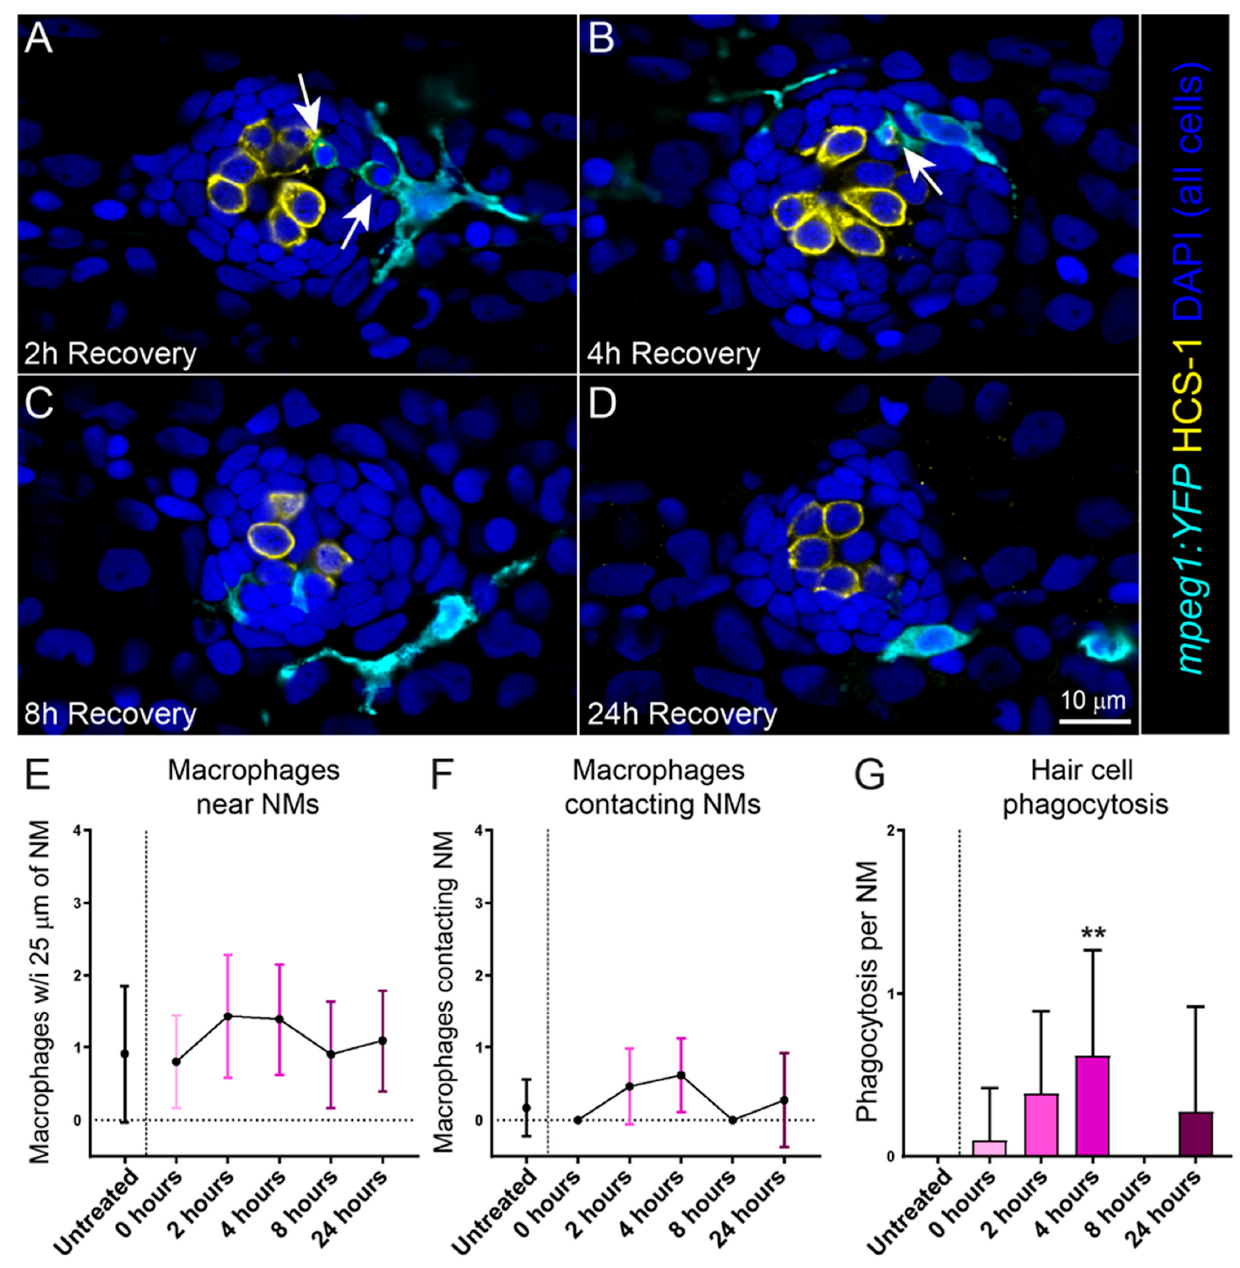
Figure 2. Macrophages respond to cisplatin-induced injury and phagocytose dying hair cells. ( A – D ) Single z-section images taken from 15 µm-depth confocal stacks of neuromasts in fish following treatment with 250 µM cisplatin. Macrophages are labeled with YFP (cyan), hair cells with an antibody to Otoferlin (HCS-1; yellow) and all cell nuclei are labeled with DAPI (blue). Arrows indicate macrophage phagocytosis of dying hair cells. Note that the macrophages at 2- and 4-h recovery ( A , B ) have internalized otoferlin-labeled hair cell debris (yellow) as well as pyknotic nuclei (blue). At later time points ( C , D ) macrophages are in proximity of neuromasts but no longer phagocytosing hair cell debris ( E , F ). Quantification of macrophages in proximity to neuromasts ( E ) and contacting neuromasts ( F ) following cisplatin. There was no observed difference between cisplatin treated and control. ( G ) Quantification of phagocytotic events in cisplatin treated neuromasts, which peaked 4 h post cisplatin treatment (Dunn’s multiple comparisons test, ** adjusted p = 0.0636). Bars = SD. Data obtained from 10–14 fish/treatment group.